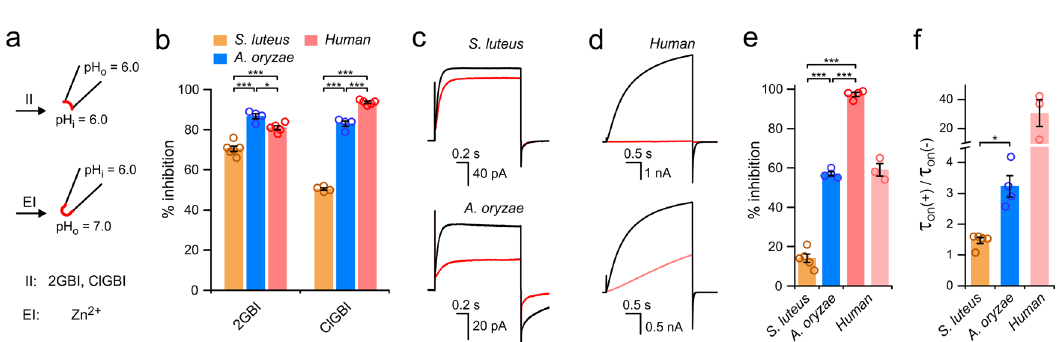
Fig. 3 Gating of fungal Hv1s is strongly Δ pH dependent. a Change in I – V relationship for SlHv1 in response to change in Δ pH from 0 to 1. b Change in I – V relationship for SlHv1 in response to change in Δ pH from 0 to − 1. Currents in a and b were measured at the indicated Δ pH in inside-out patches. Voltage was changed using ramp protocols described in “ Methods ” . Arrows represent the voltages at which the SlHv1 should start conducting measurable current ( V threshold ) if the channel followed the general behavior of animal Hv1 channels (see main text), with shifts around 40 mV per pH unit. The colors of the arrows re fl ect the corresponding Δ pH conditions. c , d G – V relationships derived from I – V curves in ( a ) and ( b ), respectively (see “ Methods ” ). e , f same as ( a ) and ( b ) but for AoHv1. g , h G – V relationships derived from I – V curves in ( e ) and ( f ), respectively. i Average shifts in V 1/2 as a function of change in Δ pH ( ΔΔ pH) measured from G – V s, like the ones shown in ( c , d ) and ( g , h ). Each bar represents the mean of 3 – 7 independent measurements ± SEM. j V 1/2 of G – V s from SlHv1 as a function of pH under symmetrical conditions ( Δ pH = 0). Each point represents the mean of 5 – 6 independent measurements. Error bars are SEM. Dashed line is the linear fi t of the data with slope = 19 ± 2 mV/pH unit. k Same as ( j ) but for AoHv1. Each point represents the mean of 3 – 4 independent measurements. Error bars (SEM) are not shown where smaller than symbols. Data are consistent with insensitivity to pH when Δ pH = 0, shown as dashed line.